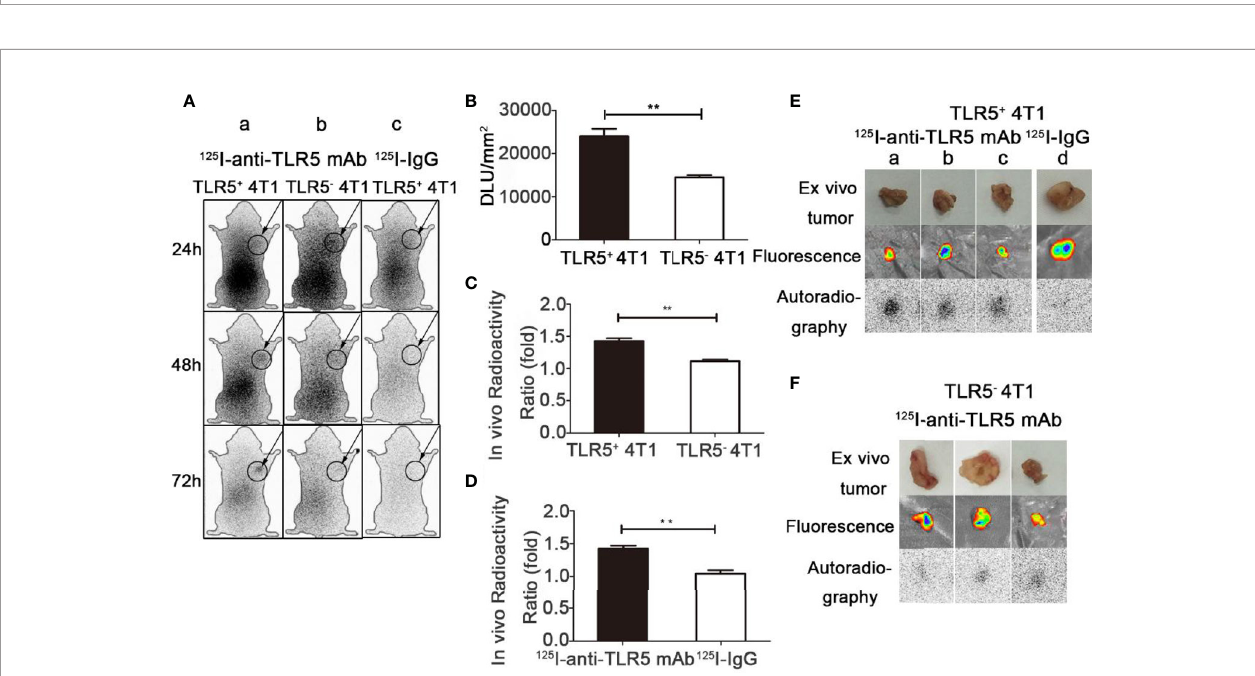
FIGURE 3 | Whole-body phosphor-autoradiography and fl uorescence imaging. Whole body phosphor-autoradiography of 125 I-anti-TLR5 mAb in TLR5 + 4T1 tumor bearing mice (A a ) and TLR5 − 4T1 tumor bearing mice (A b ) at 24, 48, and 72 h post-injection, and whole-body phosphor-autoradiography images of 125 I-IgG (A c ) in TLR5 + 4T1 tumor bearing mice at 24, 48, and 7 2h post-injection. DLU/mm 2 of TLR5 + and TLR5 ‐ 4T1 tumors (B) . Comparison of in vivo radioactivity ratio (the ratio of DLU/mm2 from tumor and opposite muscle) of TLR5 + / − 4T1 tumors in phosphor-autoradiography at 48 h (C) . Comparison of in vivo radioactivity ratio of TLR5 + 4T1 tumors between 125 I-anti-TLR5 mAb and 125 I-IgG (D) . Phosphor-autoradiography and fl uorescence imaging of isolated TLR5 + 4T1 tumors in 125 I-anti-TLR5 mAb group (E a – c ) , and 125 I-IgG group (E d ) . Phosphor-autoradiography and fl uorescence imaging of isolated TLR5 − 4T1 tumor in 125 I-anti-TLR5 mAb group (F) . The data were presented from three independent experiments and analyzed by Student ’ s t test. **P <